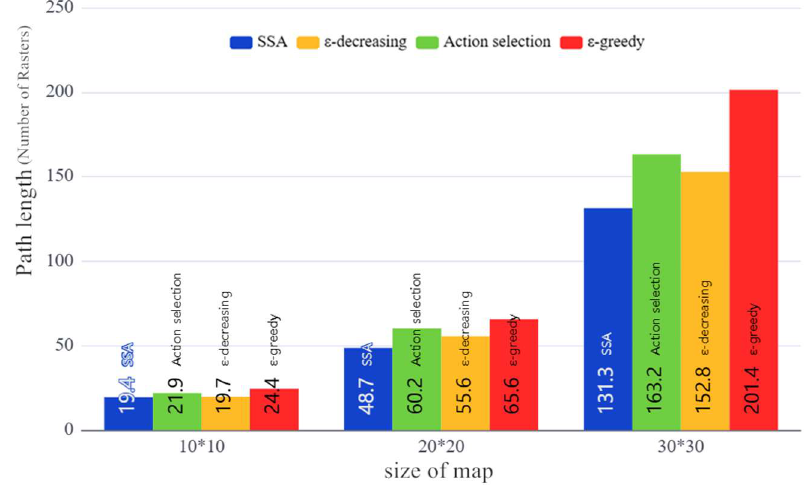
Figure 11. Path length comparison chart.